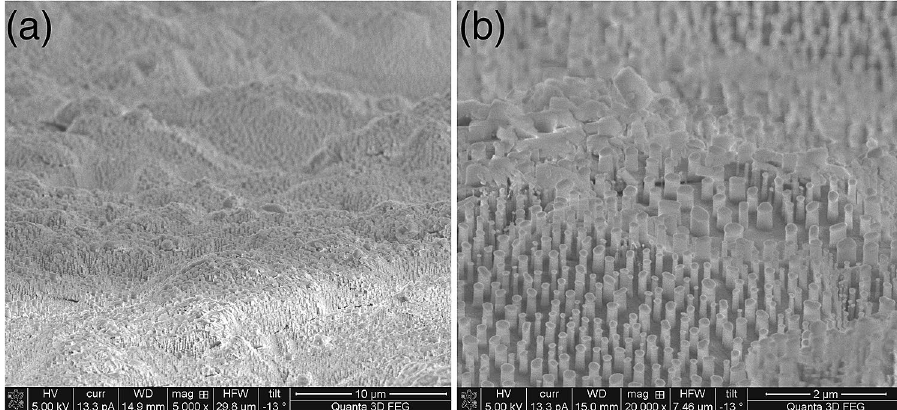
Figure 3. ( a ) The SiO 2 layer immediately after RIE plasma etching, with Au nanomask still in place; ( b ) a close up to show verticality of SiO